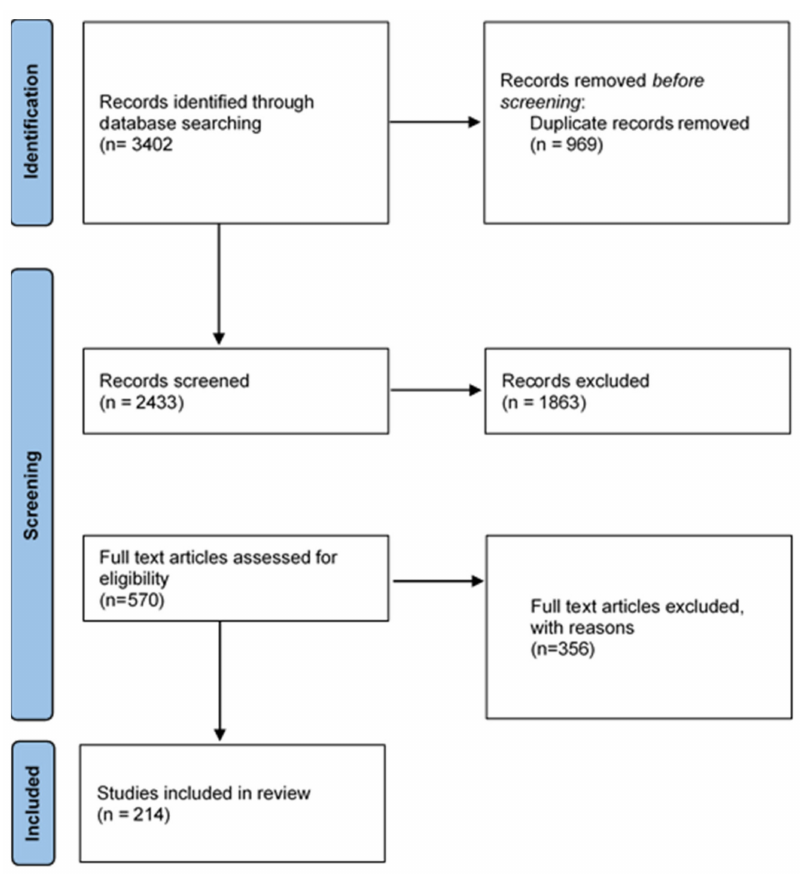
Figure 1. Flow diagram presenting the search strategies used, based on the PRISMA statement reporting guidelines for systematic literature reviews